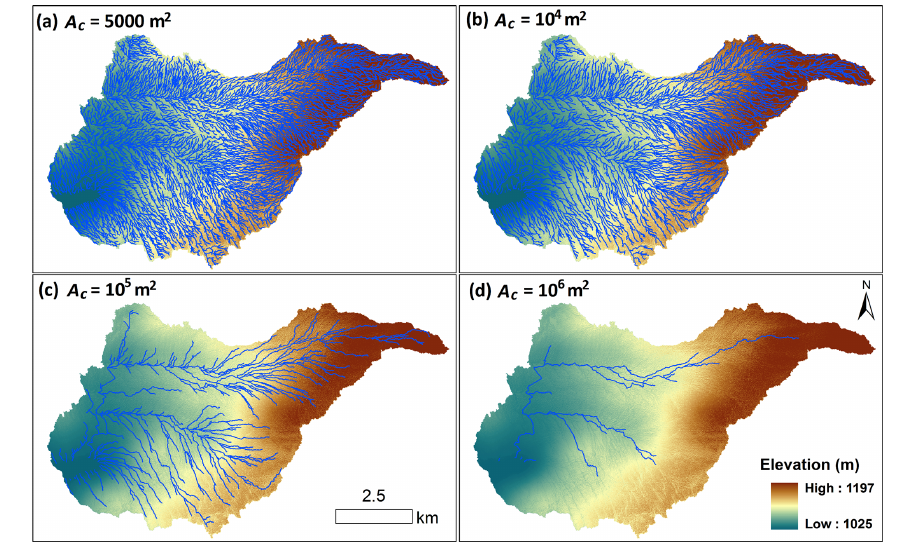
Figure 6. Variable supraglacial stream and river network for IDC1, as simulated by applying variable accumulative area threshold (channel initiation threshold, A c ) values to